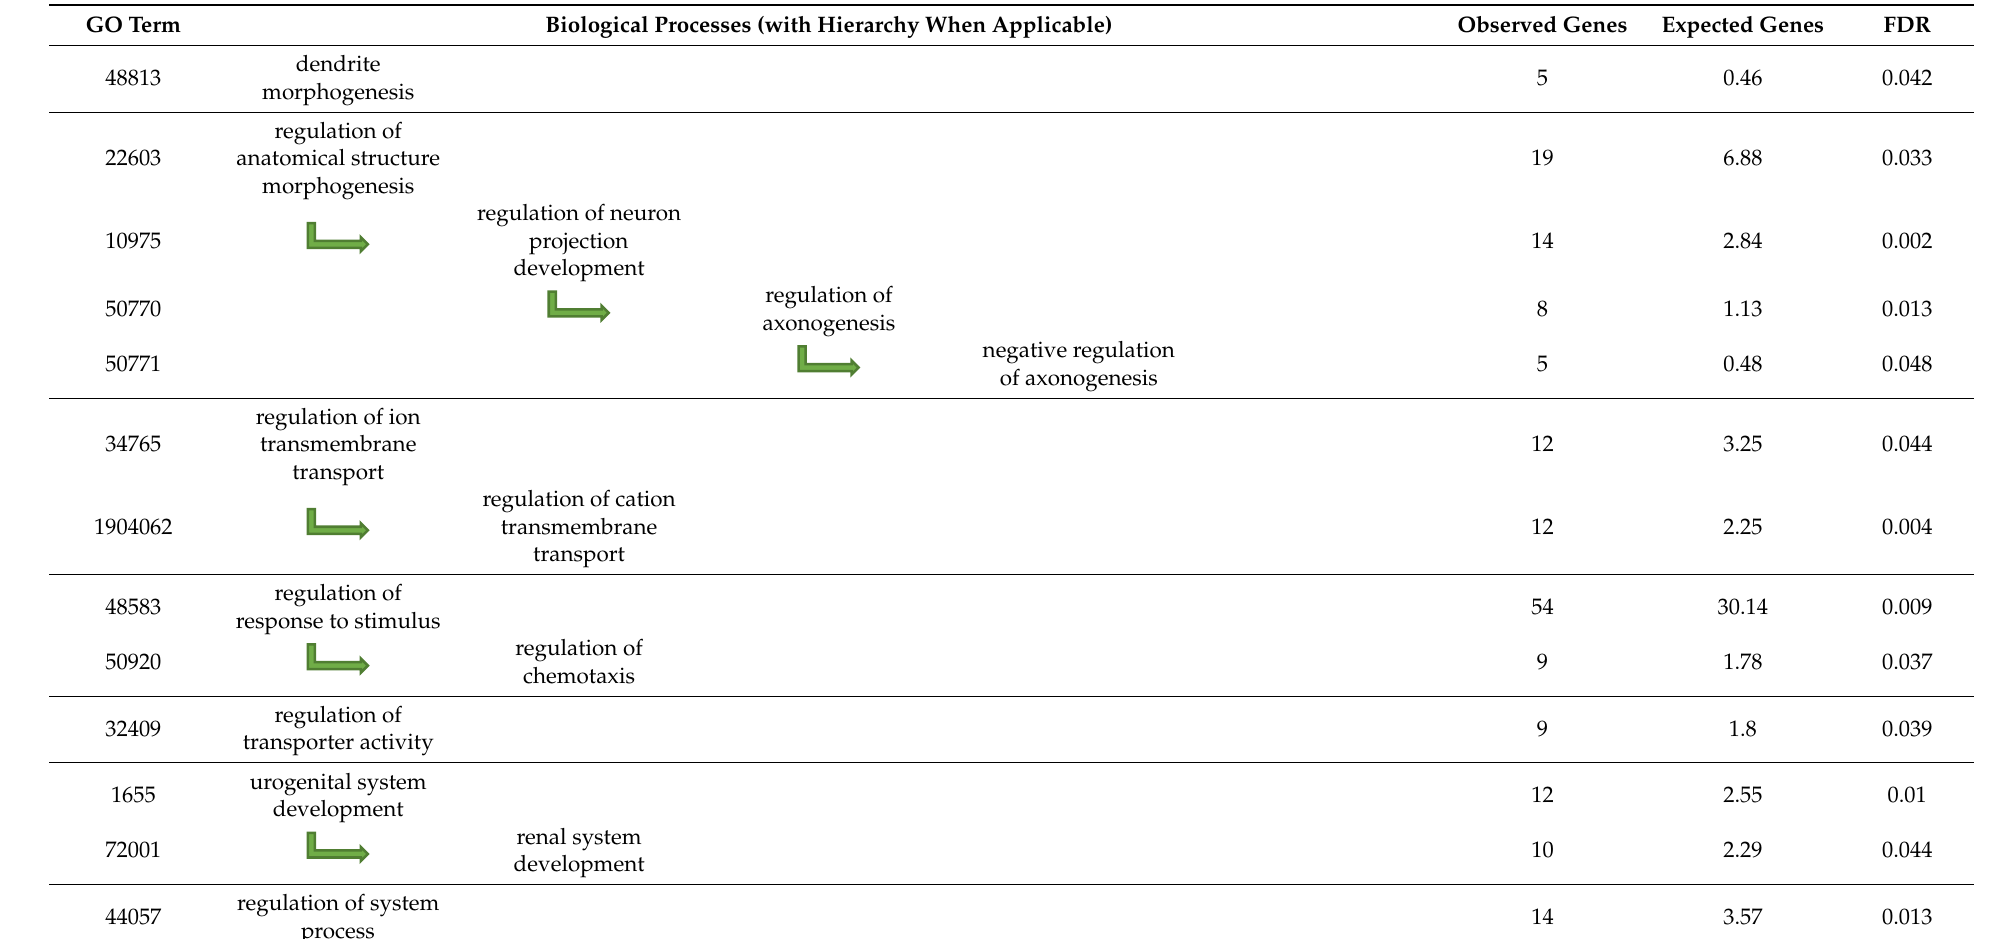
Table 5. Gene Ontology analysis for genes associated with total number born, number born alive, number of stillborn, litter birth weight, and corpus luteum number in pigs.